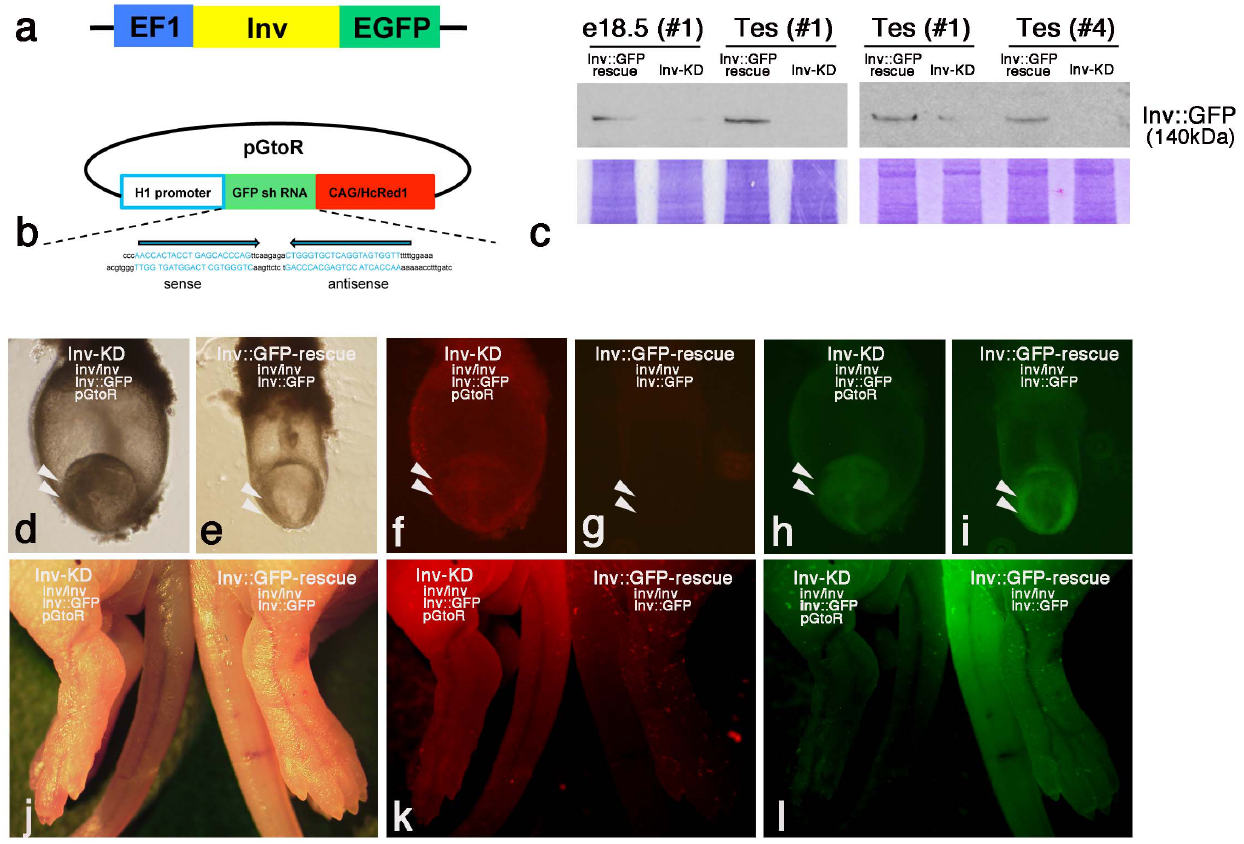
Figure 1. shRNA-based gene silencing of the Inv::GFP fusion gene. a: Construct of the Inv::GFP fusion gene introduced into Inv::GFP-rescue mice. EGFP coding cDNA was fused to the C terminus of Inv coding cDNA and inserted downstream of the EF1 a promoter [28]. b: Construct of the pH1/siRNAEGFP-CAG/HcRed1 (pGtoR) transgene. Two oligonucleotides containing sense and antisense 21 nt sequences from the EGFP coding region and a spacer sequence that provided a loop structure were inserted downstream of the H1 promoter [6]. HcRed1 coding cDNA was inserted into the vector downstream of the CAG promoter. c: Western blot analysis of Inv::GFP protein of embryonic day 18.5 (e18.5) embryos and adult testis. The lysates of e18.5 embryos ( # 1 line) and adult testis ( # 1 and # 4 line) of pGtoR-integrated Inv-KD mice ( inv/inv , Inv::GFP , pGtoR ) and control litter mate Inv::GFP-rescue mice ( inv/inv , inv::GFP ) were analyzed by western blotting with anti-GFP antibodies. A band of approximately 140 kDa of Inv::GFP fusion protein was detected in Inv::GFP-rescue mice, but was specifically down-regulated in the pGtoR integrated Inv-KD mice embryos